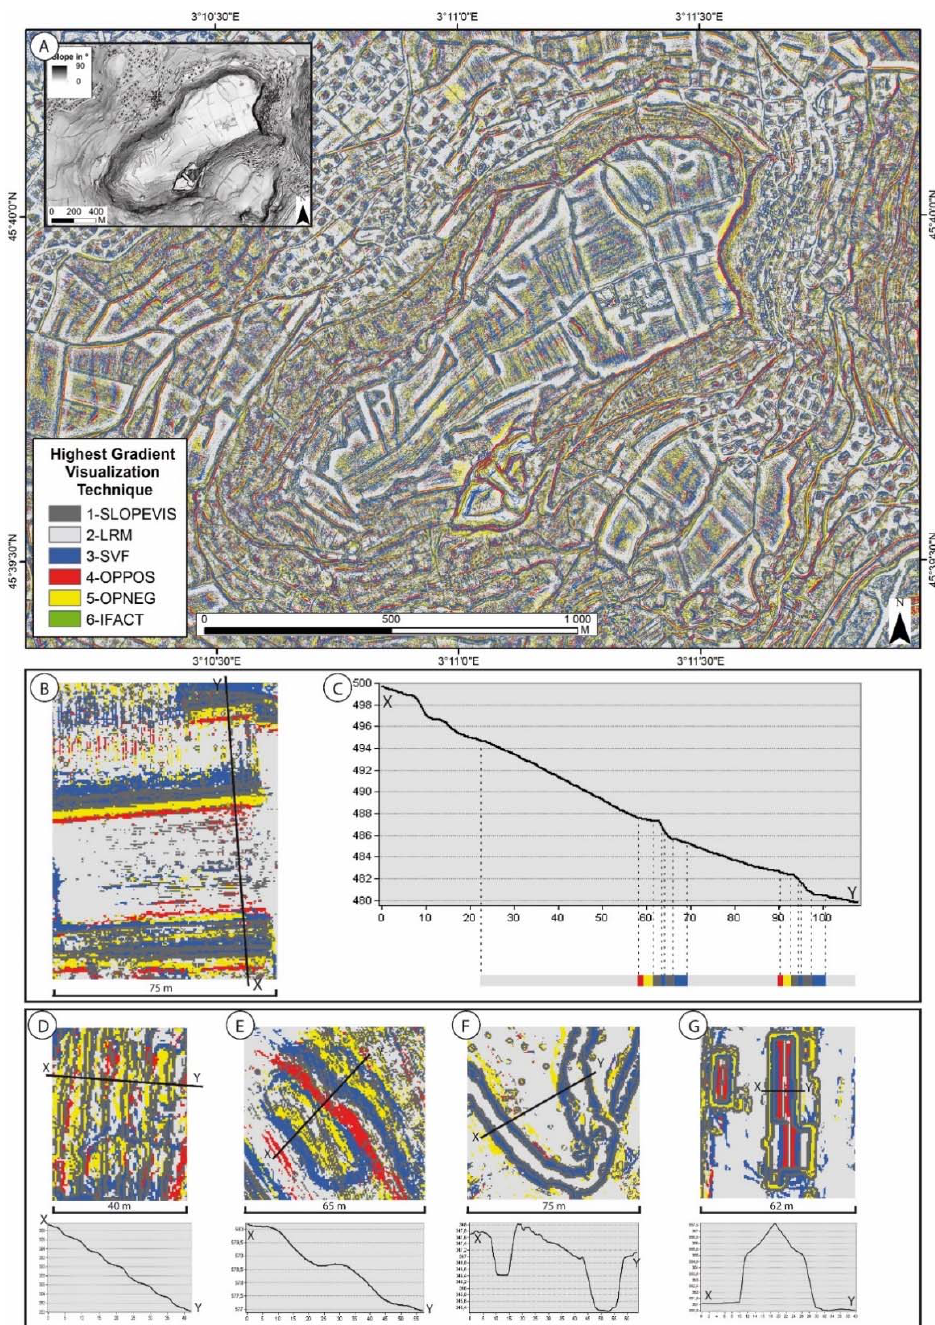
Figure 6. General overview of Highest Gradient Model and detailed examples. ( A ) Extract of the HGM showing Corent volcanic plateau area; ( B ) recent agricultural terraces (XY segment represents profile C); ( C ) topographic profile of recent terraces and its corresponding HGM signature; ( D ) eroded agricultural terraces; ( E ) undetermined mound; ( F ) small river channels; ( G ) buildings.